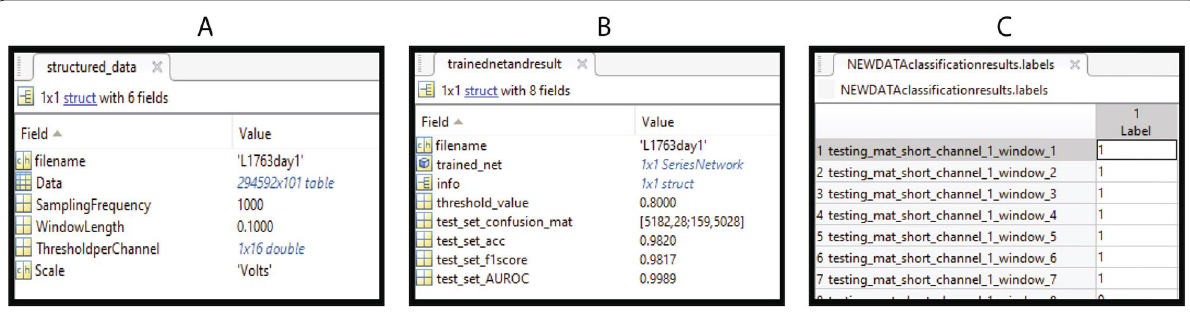
Fig. 12 Screenshots of the toolbox’s saved files: labeled data ( A ), trained network and results ( B ), and new data labels ( C